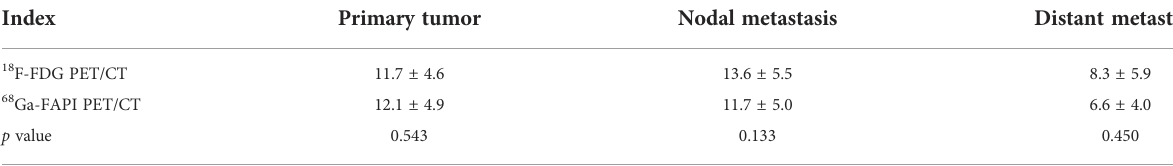
TABLE 2 The SUVmax comparison between 18 F-FDG and 68 Ga-FAPI-04 PET/CT in primary tumor, nodal, and distant metastasis. Index Primary tumor Nodal